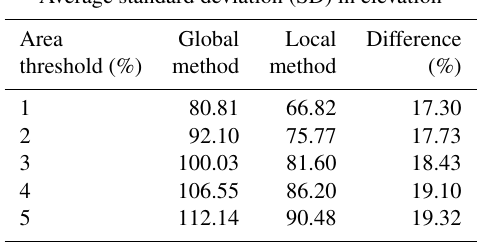
Table 1. Comparing the local and global methods in capturing to- pographic heterogeneity when using non-geo-located